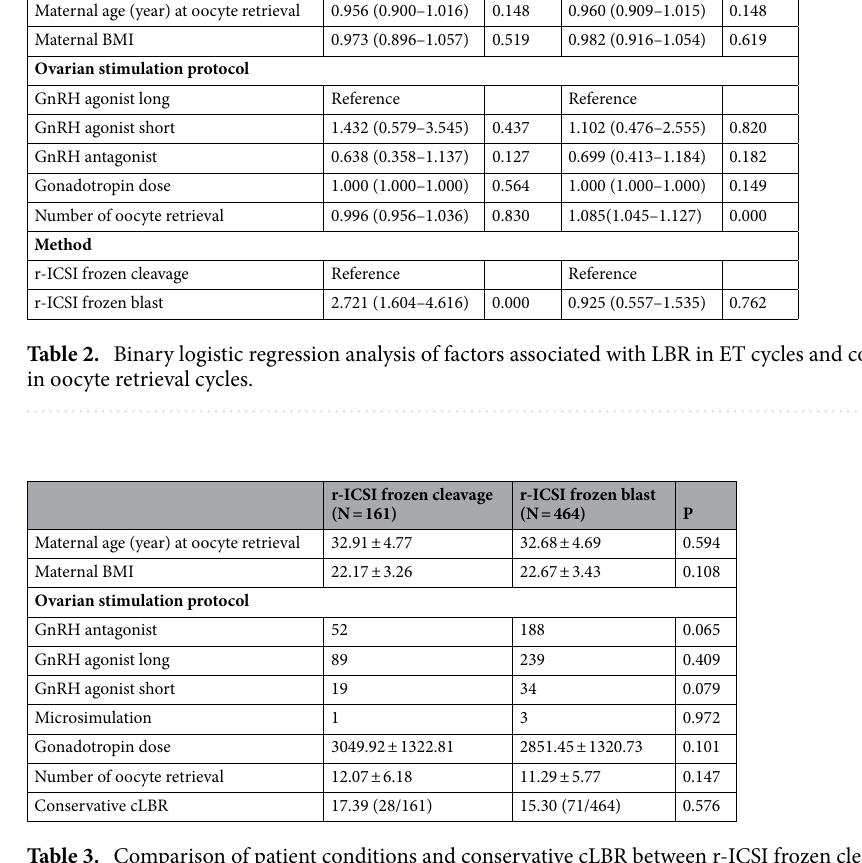
Table 3. Comparison of patient conditions and conservative cLBR between r-ICSI frozen cleavage and r-ICSI frozen blast groups. Data are % (n/N) or the mean ± SD. cLBR: cumulative live birth rate.